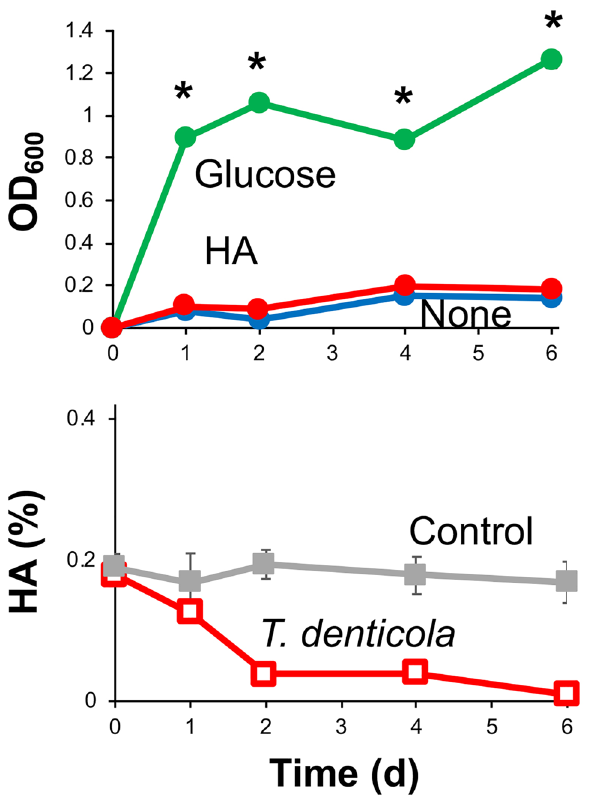
Figure 2. HA assimilation by T. denticola . Growth of T. denticola in nutrient-poor medium (1/20 × Gifu anaerobic medium (GAM); blue) or in the same liquid medium but containing glucose (green) or HA (red) as a carbon source (top). * p < 0.05, significant growth promotion compared to growth in nutrient-poor medium ( t test). HA concentrations during growth in HA-containing medium were determined (bottom). T. denticola degraded